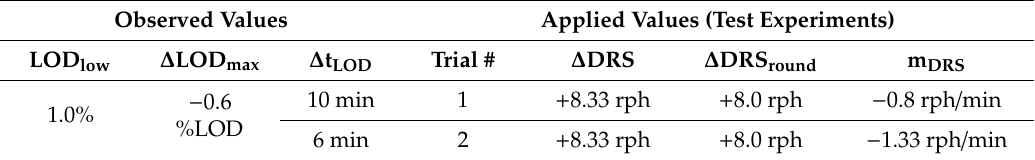
Table 1. Overview of applied ramp height and slope in the two performed test experiments, calculated from observed LOD values and estimated equilibration times shown in Figure 3. (Calibration factor CF = + 0.072% LOD / rph. Due to technical constraints, calculated ∆ DRS was rounded to the nearest whole number ( ∆ DRS round ). See Equations (2) to (4) for details on the calculation). Observed Values Applied Values (Test